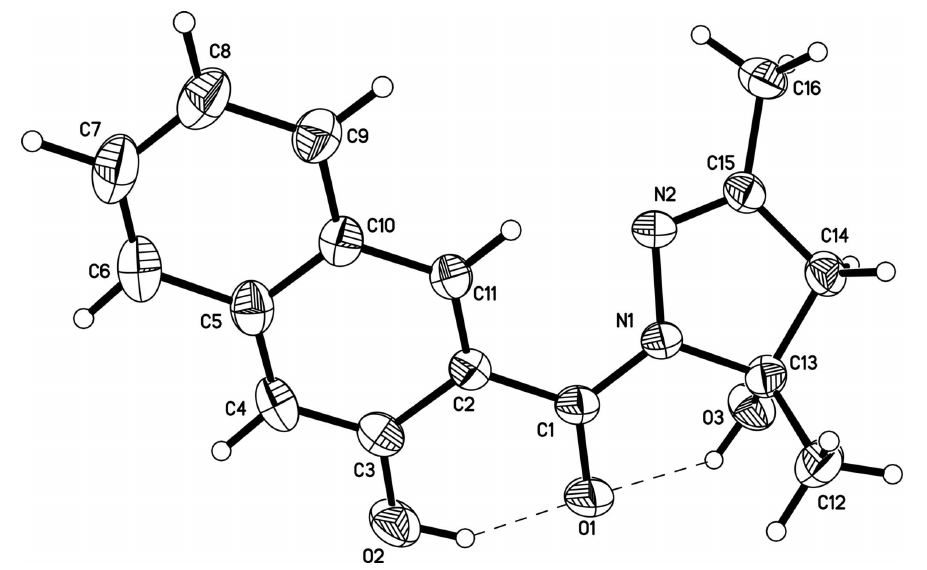
The molecular structure of the title compound showing the atomic numbering and 30% probability displacement ellipsoids. Dashed lines denote hydrogen